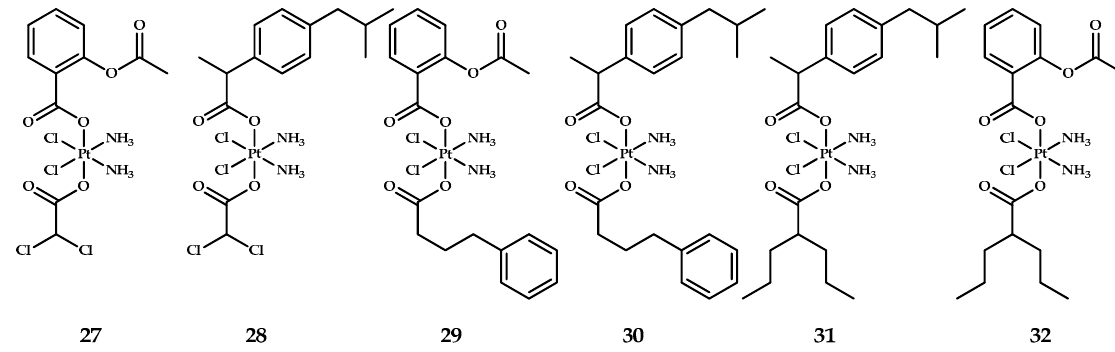
Figure 13. Cisplatin-based triple action prodrugs 27–32 with ibuprofen ( 28 , 30 , 31 ), aspirin ( 27 , 29 , 32 ), dichloroacetate ( 27, 28 ), phenylbutyrate ( 29, 30 ) and valproate ( 31 , 32 ) moieties in axial positions.